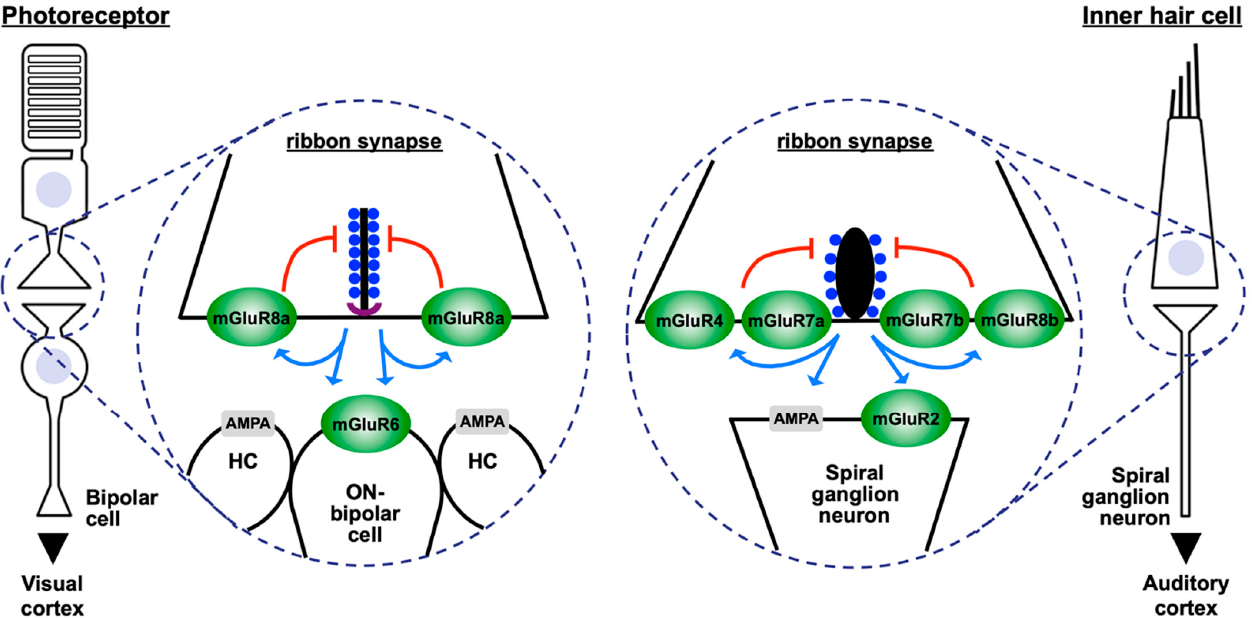
Figure 1. Inhibitory feed-back loops in sensory receptors of the retina and cochlea. Photoreceptors of the mammalian retina and inner hair cells of the cochlea form ribbon synapses that can be identified by the presence of an electron-dense pre-synaptic elongated structure close to the active zone. The circles (blue dashed lines) visualize enlargements of the ribbon synapses of both sensory cells. ( Left ) The pre-synaptic ribbon of photoreceptors is represented by a black bold vertical line that is anchored to the pre-synaptic membrane by proteins of the arciform density (purple). MGluR8a is the only glutamate receptor discovered to date at the photoreceptor pre-synapse. A subset of post-synaptic localized bipolar cells, termed “ON-bipolar cells” express mGluR6. Together with two post-synaptic processes of horizontal cells (HC), bipolar cell dendrites form a so-called triad at photoreceptor ribbon synapses. ( Right ) In contrast to the plate-like form of the pre-synaptic ribbon of photoreceptors, the ribbon of inner hair cells is more spherical. At inner hair cell ribbon synapses, mGluR4, mGluR7a, mGluR7b, and mGluR8b were found at the pre-synaptic site, while mGluR2 was localized at post-synaptic processes that are formed by spiral ganglion neurons. In both neuron types, synaptic vesicles filled with the excitatory neurotransmitter glutamate (blue spheres) are tethered to the sides of the ribbon. Upon stimulation of the sensory neurons, glutamate is released into the synaptic cleft, where it activates pre- and post-synaptic glutamate receptors (blue arrows). Activation of pre-synaptic mGluRs in photoreceptors and inner hair cells could initiate negative feed-back loops that inhibit the release of glutamate into the synaptic cleft (red lines). This, in turn, could reduce pre-synaptic activity which might prevent excitotoxic effects on post-synaptic neurons. In this sketch, only group II and III mGluRs are shown, while group I mGluRs present in bipolar cells and spiral ganglion neurons are not represented. As an example of post-synaptically localized ionotropic glutamate receptors, AMPA-type glutamate receptors are shown as grey rectangles, while ionotropic glutamate receptors of the NMDA and kainate type are not visualized for the sake of clarity. Piccolino, RIM, and other proteins associated with the ribbon are not shown. Ribbons are anchored to the pre-synaptic membrane of the active zone via a direct protein–protein interaction between ribeye and bassoon [14,15]. Bassoon is a major